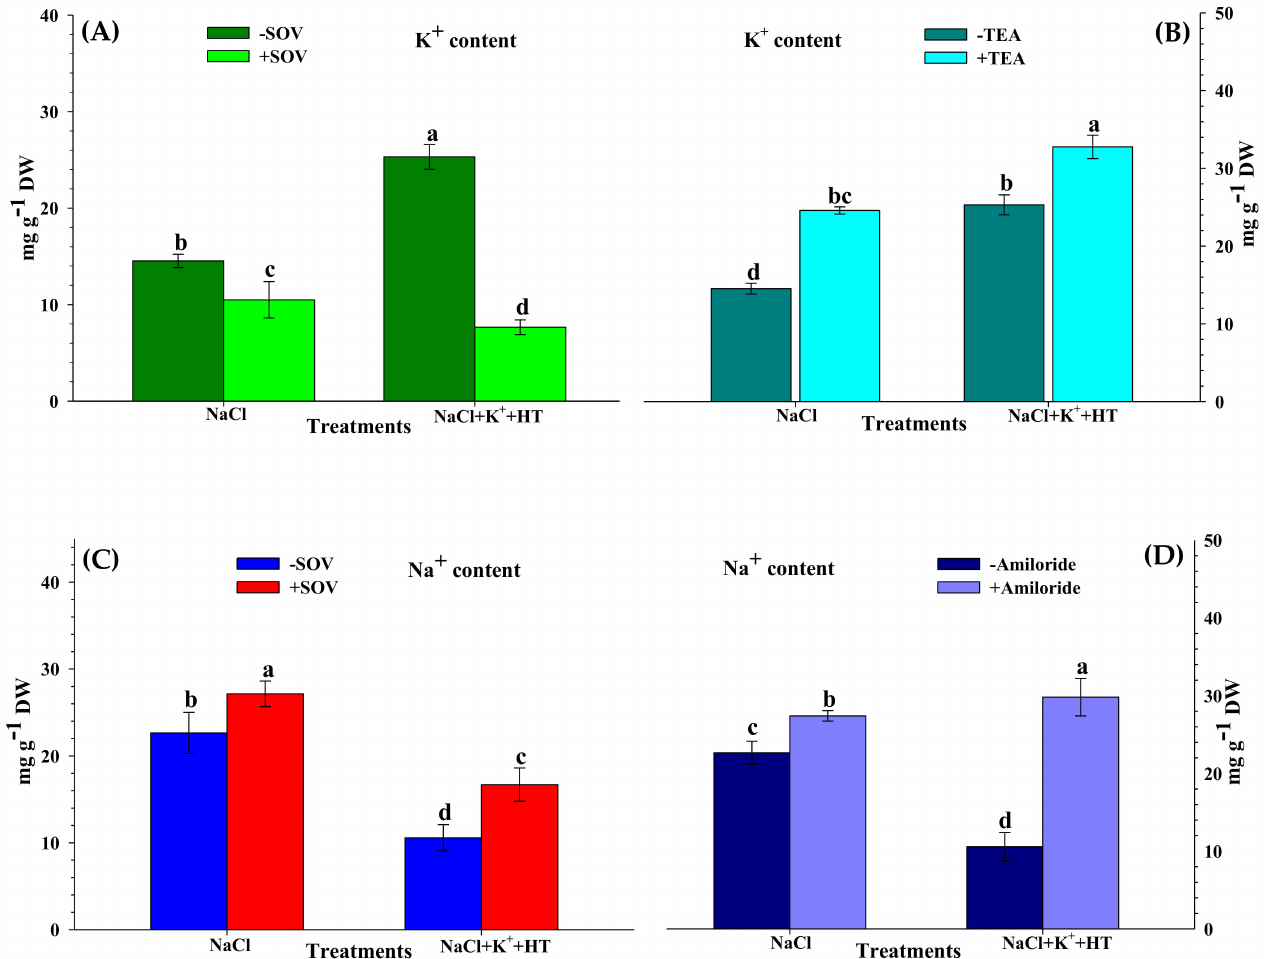
Figure 3. Effect of PM inhibitors on K + and Na + content in the presence or absence of K + and HT in NaCl-stressed (48 h) tomato roots. Effect of SOV ( A ) and TEA ( B ) on K + content, effect of SOV ( C ) and amiloride ( D ) on Na + content. Addition of 500 µ M sodium orthovanadate (SOV, PM H + -ATPase inhibitor), 20 mM tetraethylammonium chloride (TEA, K + channel blocker), 50 µ M amiloride (Na + /H + antiporter inhibitor), 1 mM hypotaurine (HT: H 2 S scavenger), 5 mM K 2 CO 3 (K + ), 100 mM NaCl (NaCl). Values are means of five independent replicates, with bars indicating SE. Bars with different letters indicate that differences were statistically significant at p < 0.05